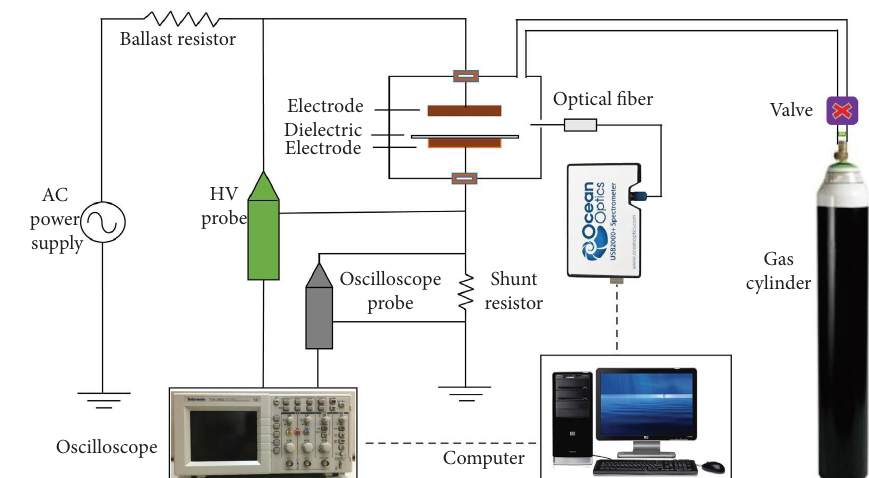
Figure 1: Image of the experimental